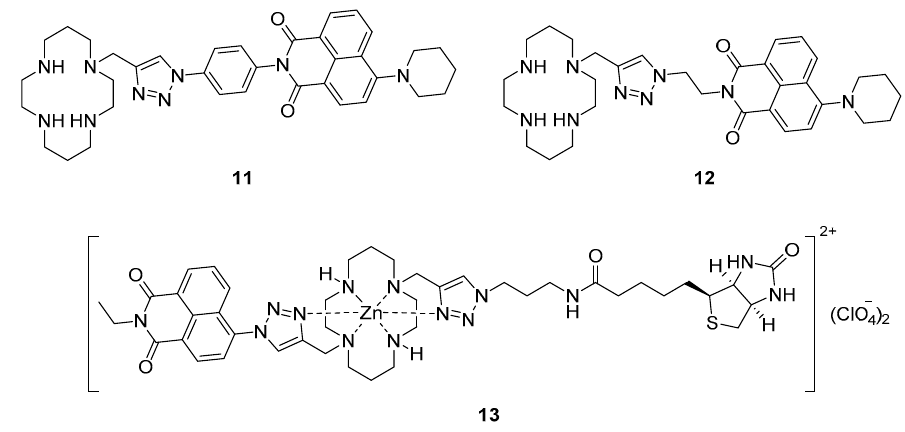
Figure 5. The cyclam-piperidinylnaphthalimide conjugates 11 and 12 are turn-off probes for Cu 2+ , while the Zn 2+ complex 13 of a biotinylated cyclam-naphthalimide enables visualization of the biotin/ avidin binding interaction using fluorescence.